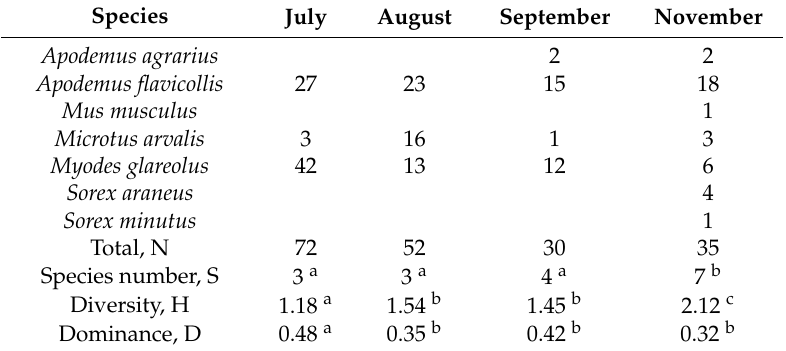
Table 2. Changes in the composition in the small mammal community in homesteads.